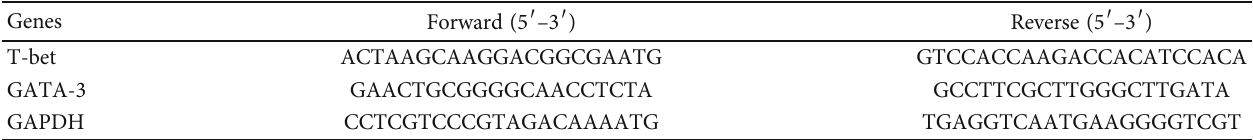
Table 1: Primers used for quantitative RT-qPCR.